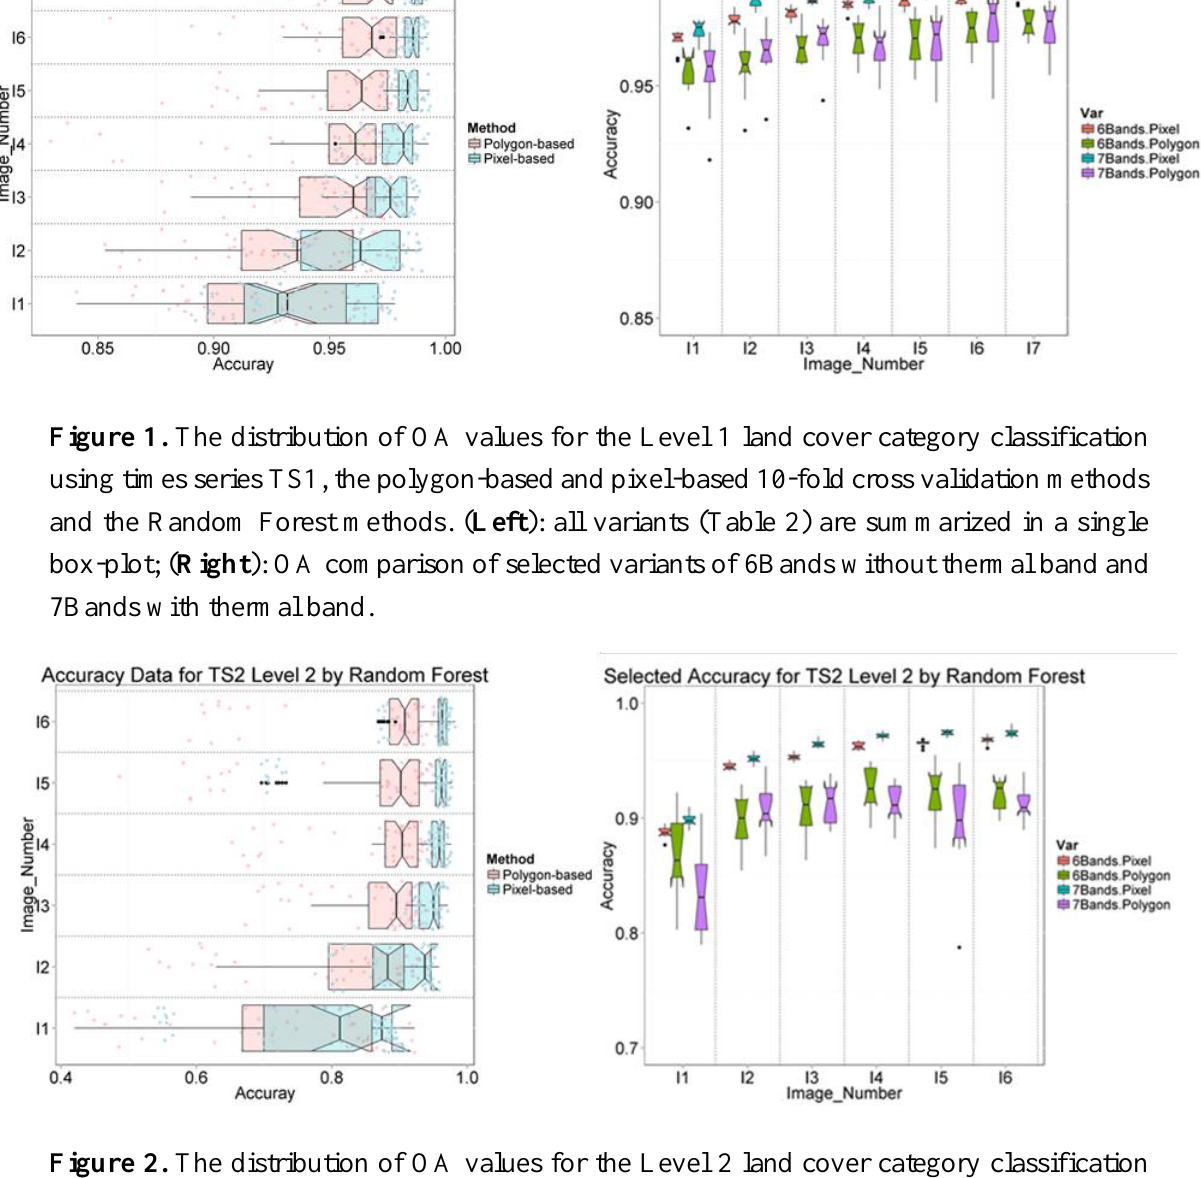
Figure 2. The distribution of OA values for the Level 2 land cover category classification using times series TS2, the polygon-based and pixel-based 10-fold cross validation methods and the Random Forest methods. ( Left ): all variants (Table 3) are summarized in a single box-plot; ( Right ): OA comparison of selected variants of 6Bands without thermal band and 7Bands with thermal